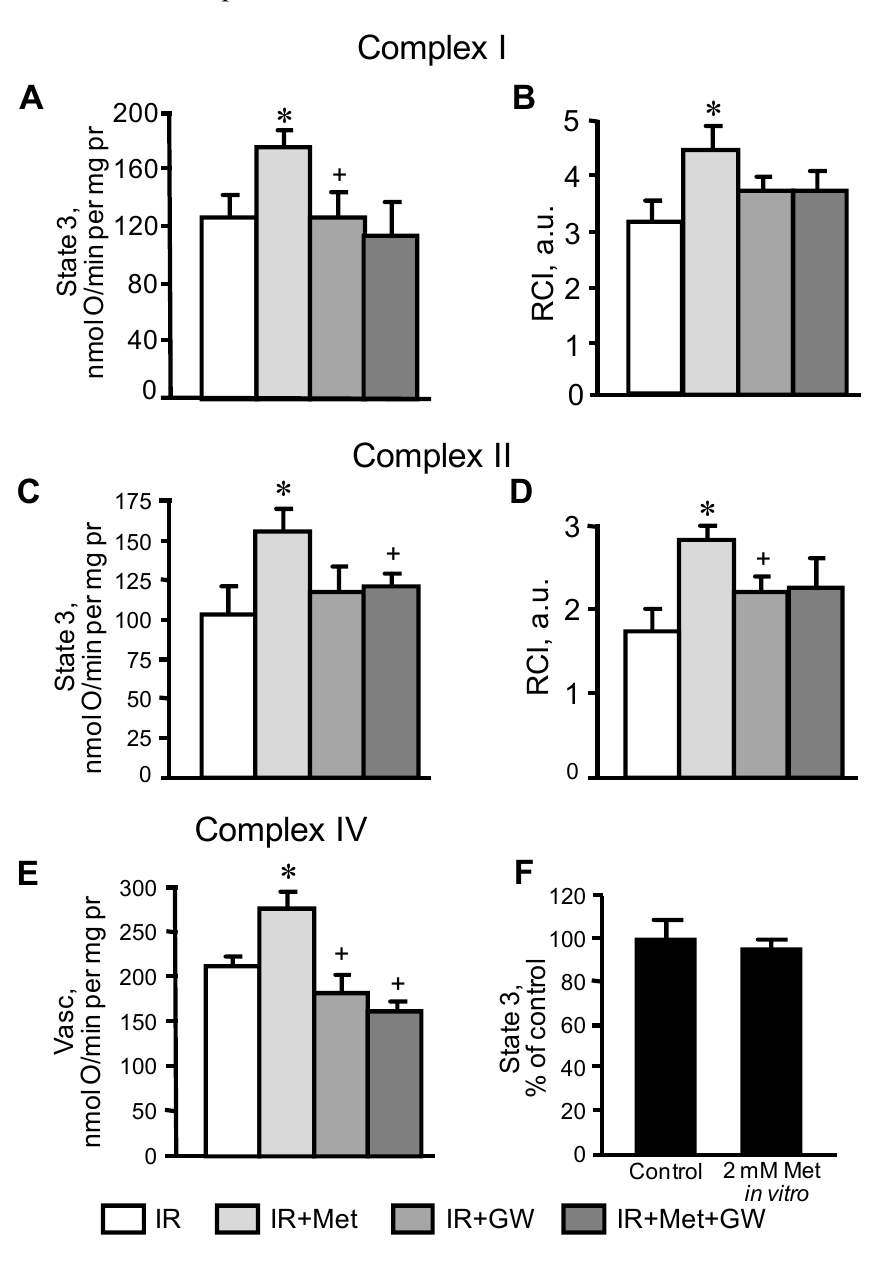
Figure 4. Respiration rates of mitochondria isolated from the IR hearts treated with metformin (Met) in the presence or absence of GW6471 (GW). ( A ) State 3 at complex I measured in presence of 2.5 mM 2-oxoglutarate and 1 mM L -malate as substrates; ( C ) State 3 at complex II measured in presence of 2.5 mM succinate as a substrate; ( E ) Respiration rate at complex IV measured in presence of 10 mM ascorbate and 0.3 mM TMPD; ( F ) A direct effect of metformin (2 mM) on state 3 at complex I. Panels B and D show the respiratory control index (RCI) values calculated as the ratio of state 3 to state 2. * p < 0.05 IR+Met vs. IR; + p < 0.05 IR+GW or IR+Met+GW vs.